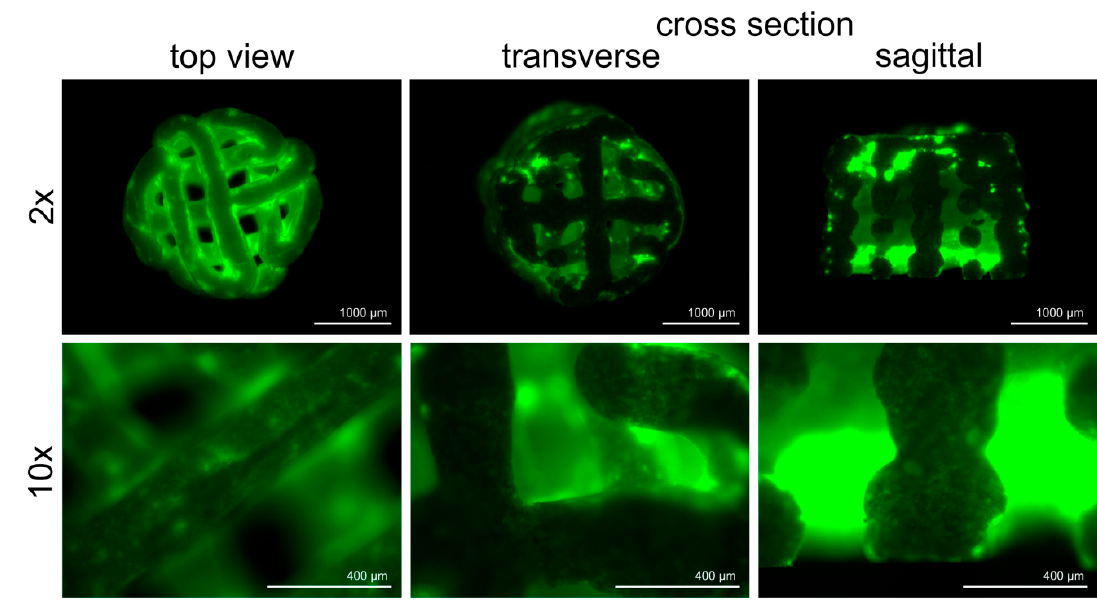
Figure 3. Qualitative evaluation of bone sialoprotein (BSP) coating. BSP was linked with fluorescein prior to the coating procedure. After several washing steps, the remaining BSP (green) was visualized via microscope.